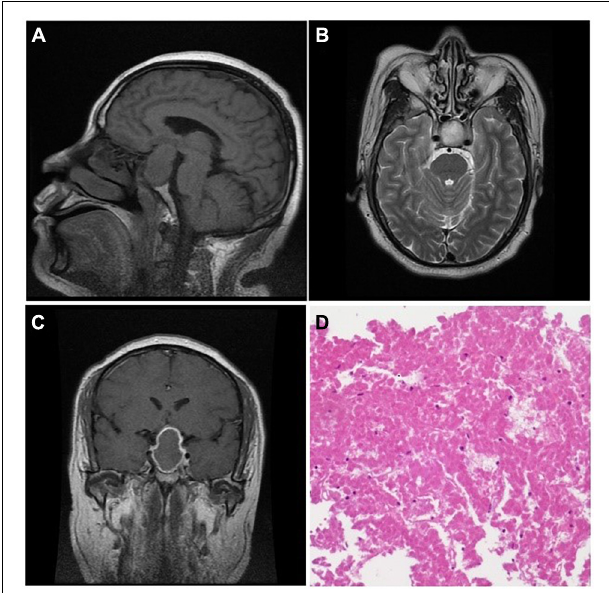
FIGURE 1 | The MRI showed iso-intensity in T1-weighted imaging ( A , sagittal) and hyperintensity in T2-weighted imaging ( B , axial). After gadolinium administration, the imaging showed central iso-intensity with an enhanced rim ( C , coronal). Histological manifestation (D) showed a large area of red massive coagulative necrosis without cellular structure (H&E × 100).